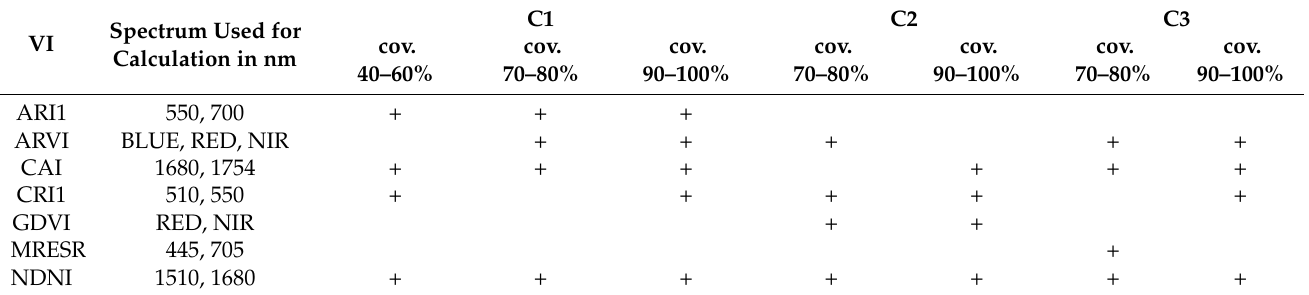
Table 4. Vegetation indices (with information about spectrum used to calculate them) listed and marked with “+” among the 10% most differentiating layers for each campaign (C1, C2, C3) and specified Rubus caesius coverage.